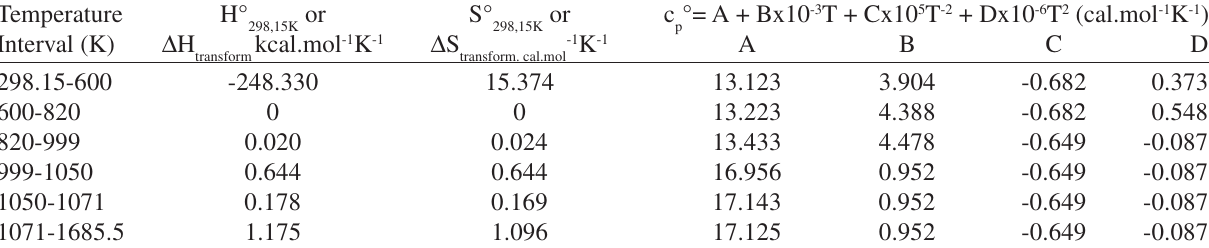
Table 3. Thermodynamic data of the species Ce function of temperature, enthalpies and entropies at 298.15K , as well as enthalpies and entropies of phase